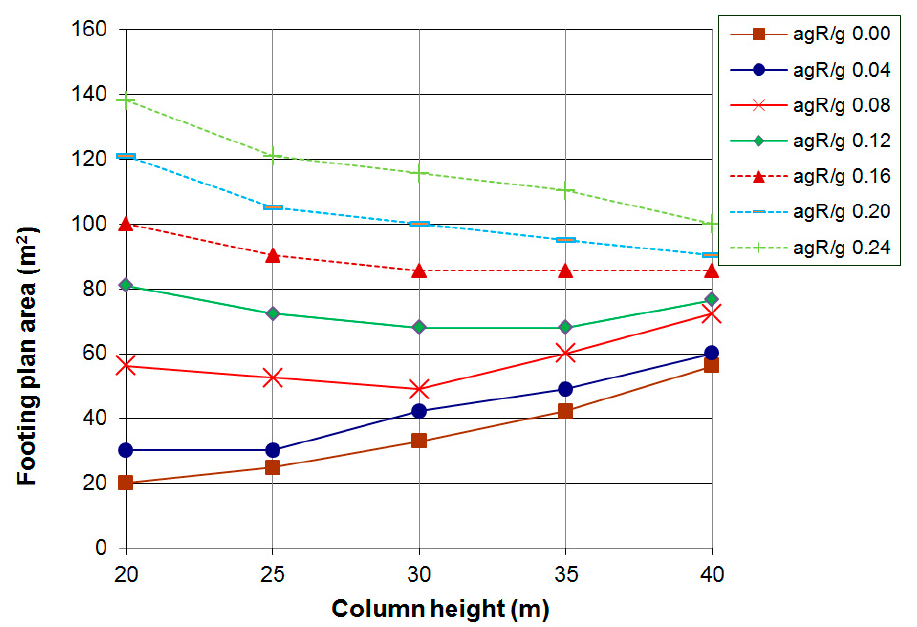
Figure 12. Area of the footing versus height of the column.